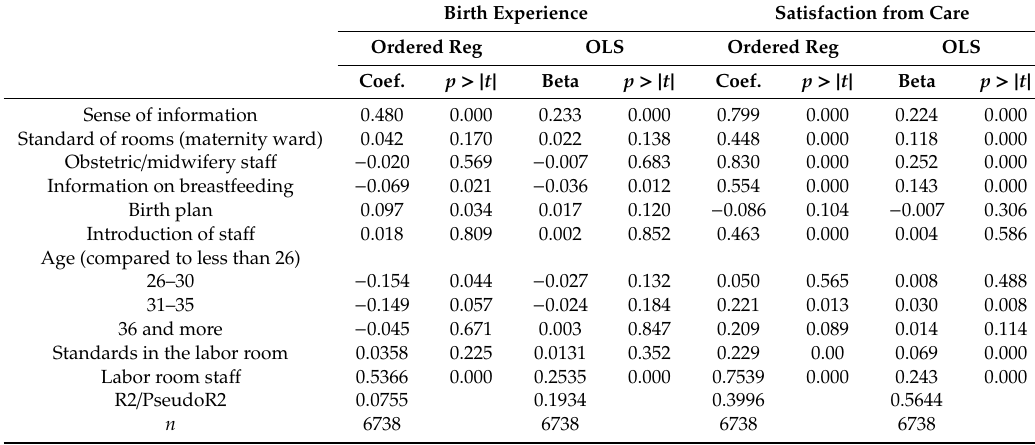
Table 4. Regression analysis excluding women that were not in the labor room ( n = 6738). Birth Experience Satisfaction from Care Ordered Reg OLS Ordered Reg OLS Coef. p > | t